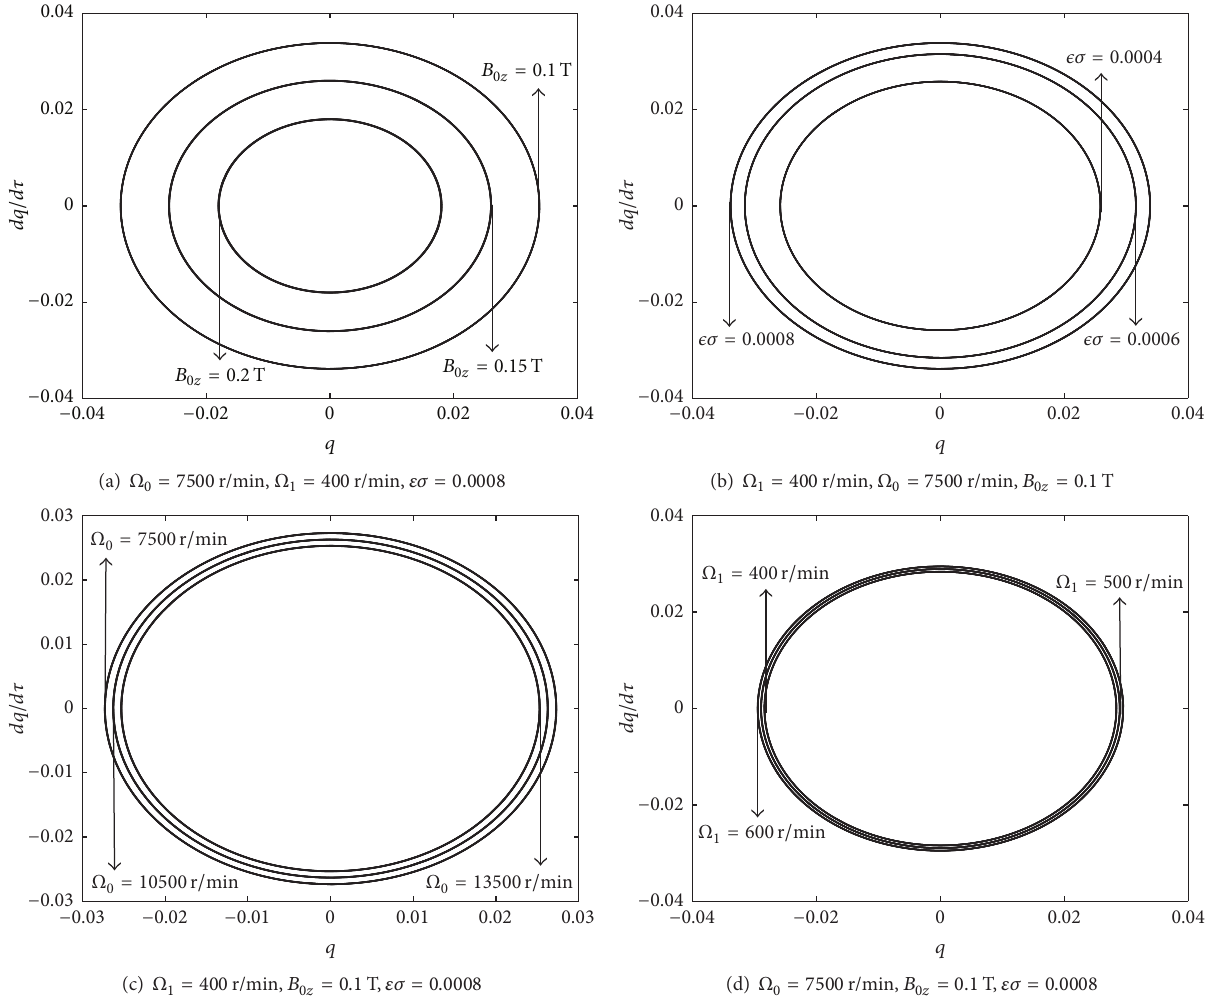
Figure 9: The phase